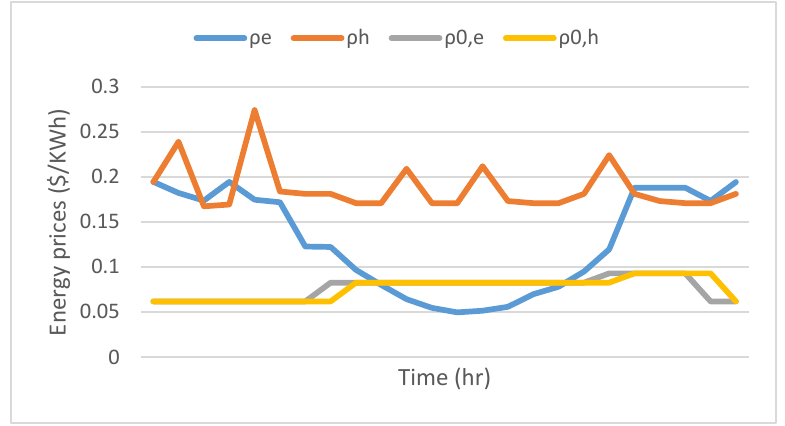
Figure 12. Base and final energy prices of responsive electric and heat loads in a winter off-day for the last year.